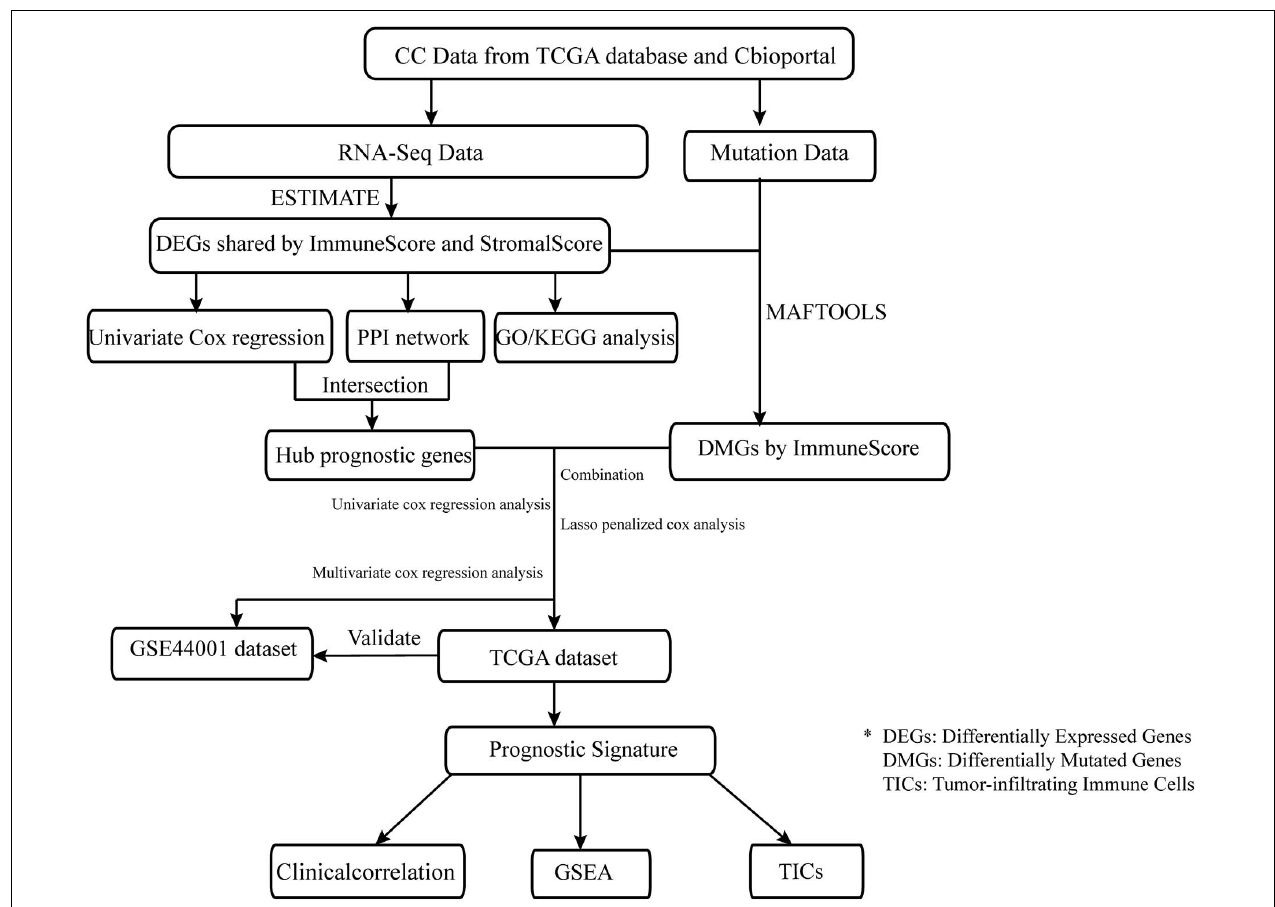
FIGURE 1 | The analysis workflow of this